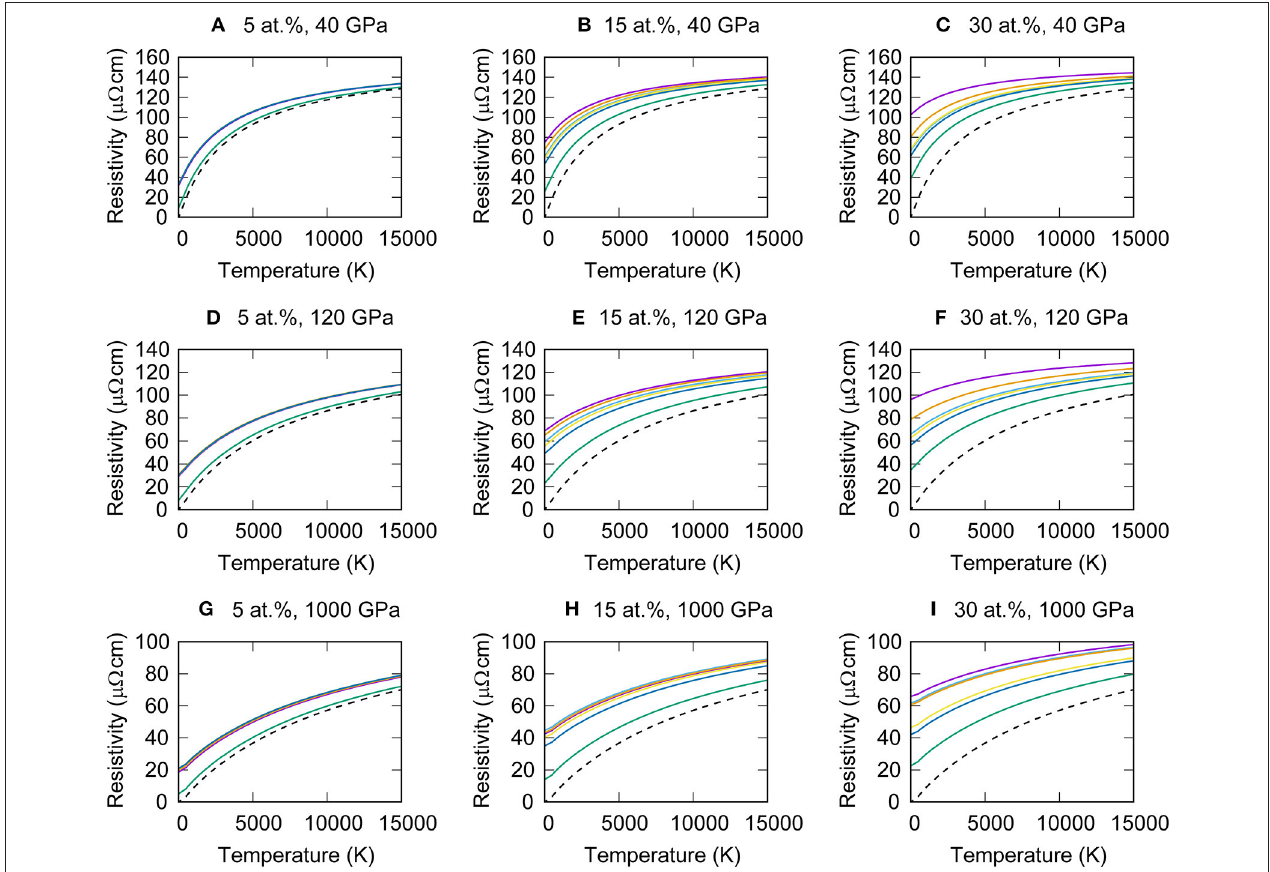
FIGURE 9 | Electrical resistivity of hcp Fe 0.95 X 0.05 , Fe 0.85 X 0.15 , and Fe 0.70 X 0.30 , where X is Si (purple), Ni (green), S (cyan), C (orange), N (yellow), and O (blue) at the volume of V = 19.10 Å 3 ( P ∼ 40 GPa at 300K) (A–C) , 16.27 Å 3 ( P ∼ 120 GPa at 300K) (D–F) , and 9.80 Å 3 ( P ∼ 1,000 GPa at 300K) (G–I) . Black broken lines are pure Fe for